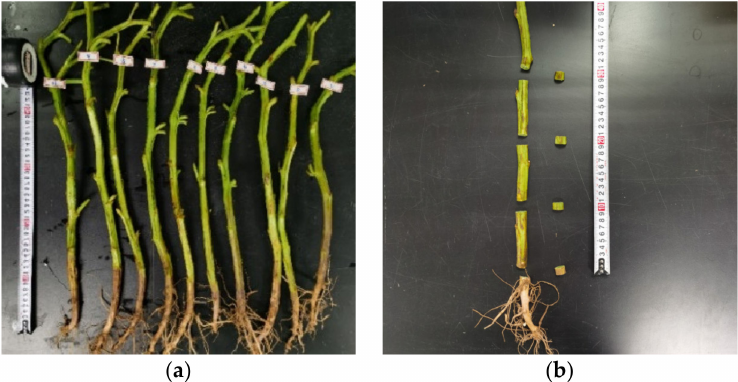
Figure 1. ( a ) Potato main stems. ( b ) Sampling location of